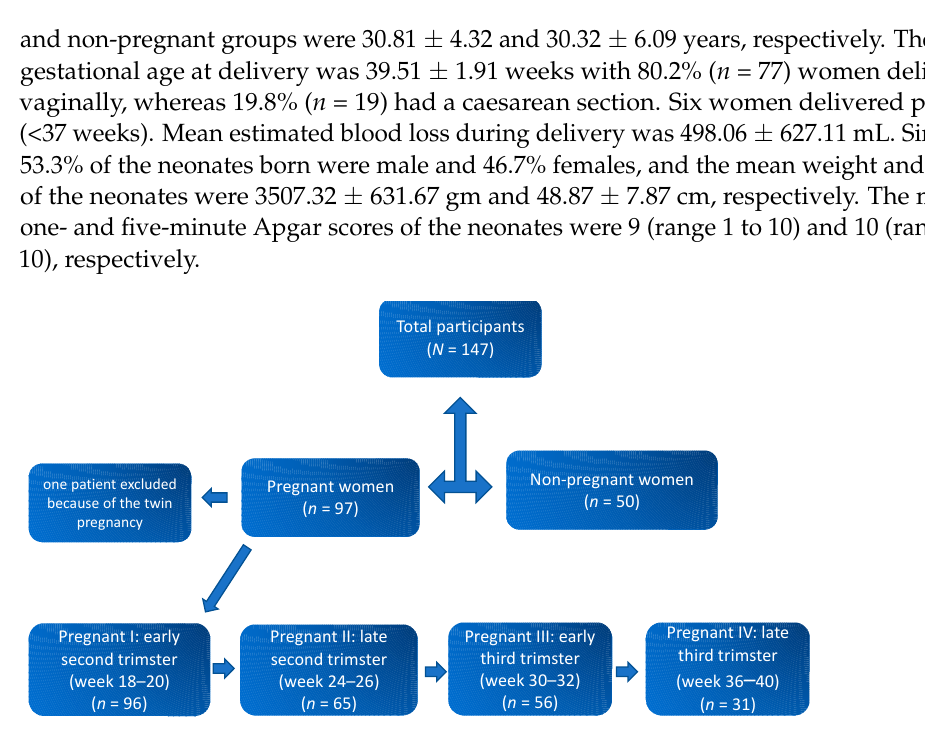
Figure 1. Chart illustrating the flow of study participants.